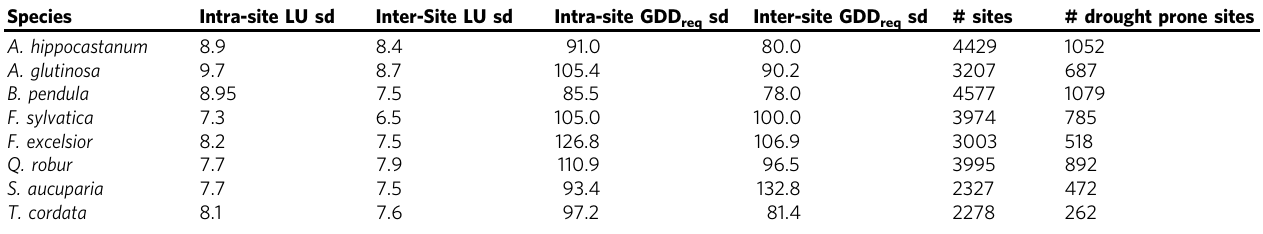
Table 1 Observed LU and GDD req